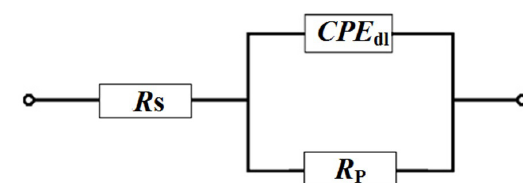
Figure 3. Equivalent circuit for the mild steel surface/corrosive media interface with CPE.